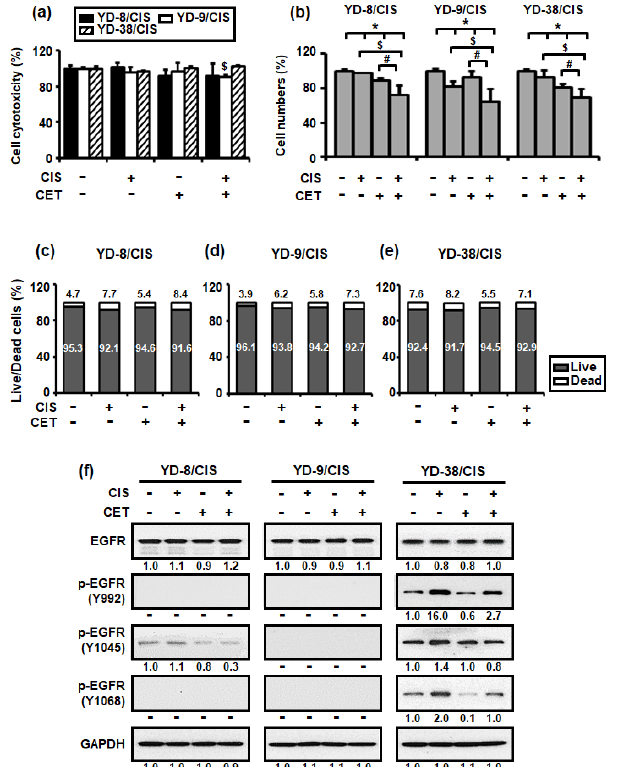
Figure 2. Combined treatment with cisplatin (CIS) (1 µ g/mL) and cetuximab (CET) (200 µ g/mL) do not induce cell cytotoxicity after 15 h but reduced cell growth after 72 h in cisplatin-resistant OSCC cells. ( a ) Cell cytotoxicity was detected using the LDH assay (mean ± SD; n = 6). * p < 0.05 versus non-treated group in YD-8/CIS cells, $ p < 0.05 versus non-treated group in YD-9/CIS cells, and # p < 0.05 versus non-treated group in YD-38/CIS cells. ( b ) The number of cells was measured using the trypan blue assay (mean ± SD; n = 6). * p < 0.05 versus non-treated group, $ p < 0.05 versus only cisplatin-treated group, and # p < 0.05 versus only cetuximab-treated group. ( c – e ) Live/dead cell ratio was calculated based on the result of ( b ). ( f ) The effects of cetuximab were confirmed using the expression levels of EGFR signaling pathway proteins in cell lysates from all three cell lines treated with cisplatin and/or cetuximab for 72 h. The levels of the indicated proteins (epidermal growth factor receptor (EGFR), phosphor-EGFR (p-EGFR) (Y992, Y1045, Y1068), and glyceraldehyde- 3-phosphate dehydrogenase (GAPDH)) were determined using the Western blot assay. Western blot results were quantified as values calculated using the Image J software. The numbers represent the ratio of the optical density of cisplatin and/or cetuximab-treated to non-treated cells normalized by